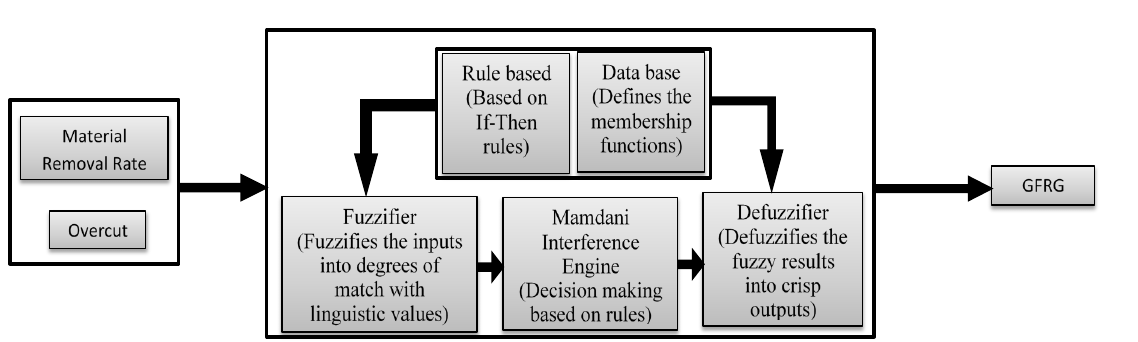
Figure 6. Two-in-one-out fuzzy Mamdani system.